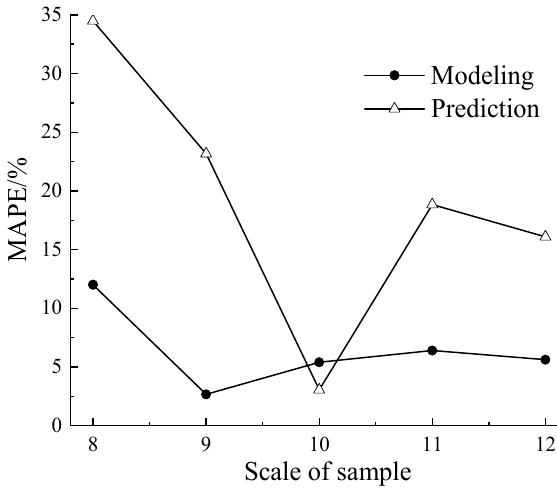
Figure 2. Accuracy comparison of different sample scale. Table 7. Comparison of POBGM (1, 5) model prediction accuracy when using a different sample scale.